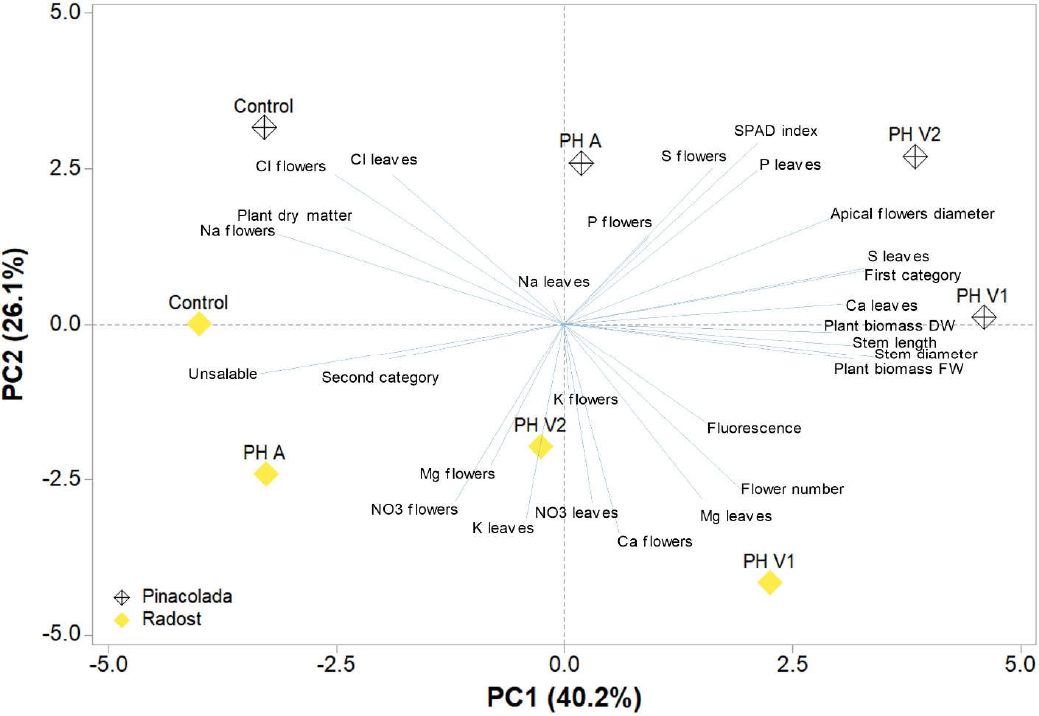
Figure 3. Principal component loading plot and scores of principal component analysis (PCA) of growth parameters (plant fresh and dry biomasses, flower number, stem diameter and length, apical flower diameter, plant dry matter), flower category (first, second, and unsaleable), SPAD index, chlorophyll fluorescence, and leaves and flowers’ mineral profile of two chrysanthemum cultivars (Pinacolada and Radost) under control, one animal PH (PH A, Hicure ® ), or two vegetal PHs (PH V1 and PH